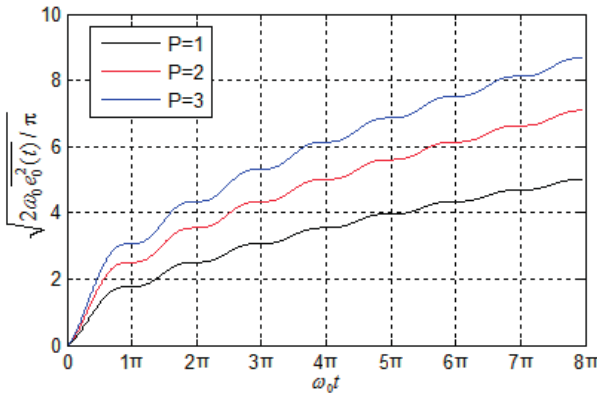
Figure 1. Curves of INS error excited by different random